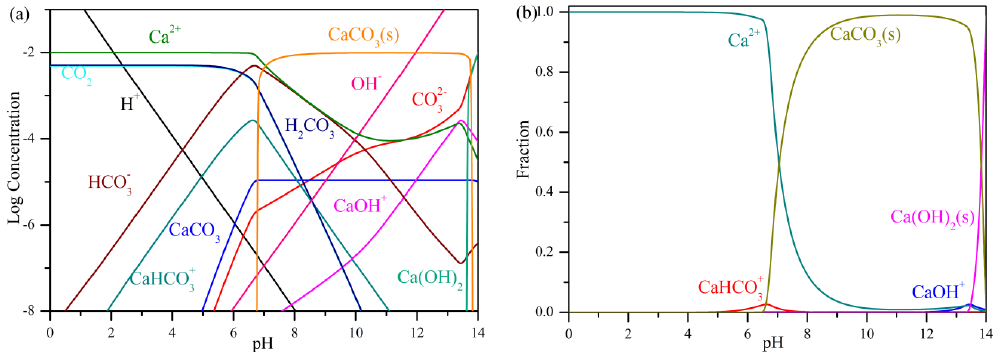
Figure 2. Calculated species distributions of 10 mM CaCO 3 at different pH: ( a ) with log concentration vs. pH; ( b ) with fraction of calcium vs. pH.